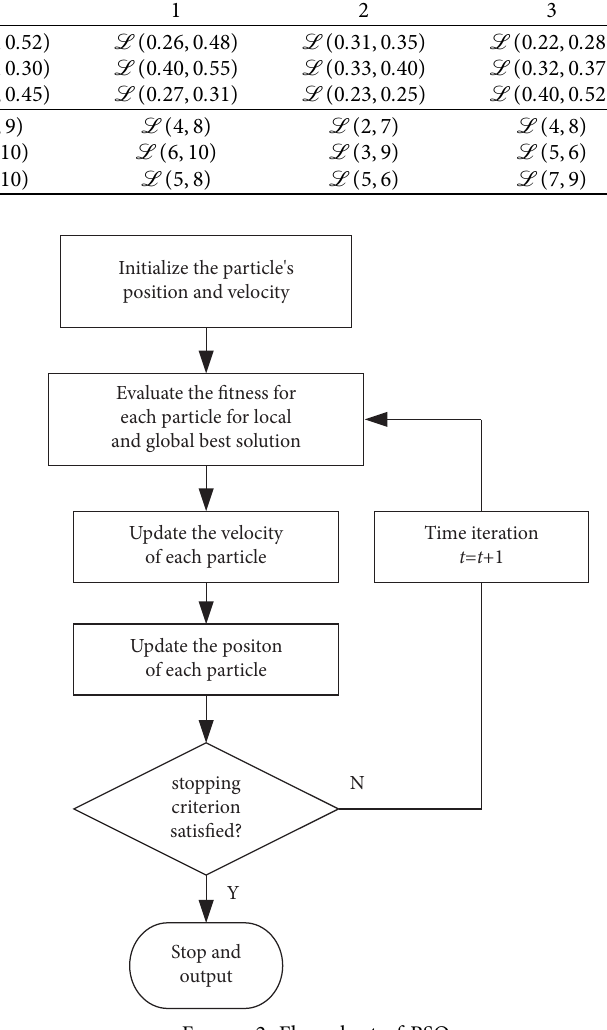
Figure 2: Flow chart of